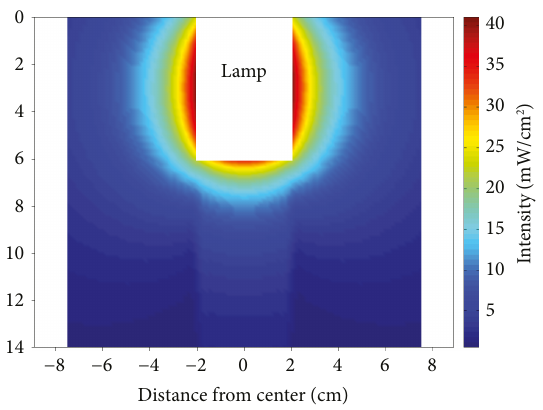
Figure 3: The light intensity distribution in the photoreactor.